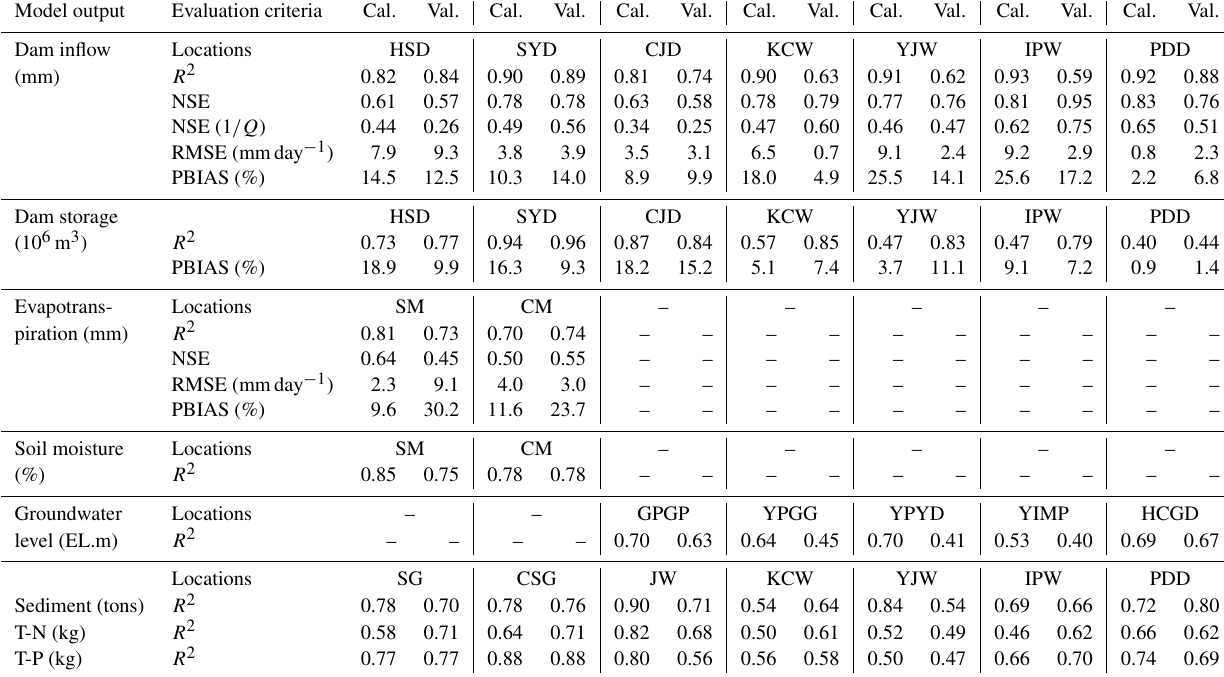
Table 2. Calibration and validation results for the dam inflow, dam-storage volume, evapotranspiration and soil moisture, groundwater-level fluctuation, sediments, T-N, and T-P at each calibration point. Model